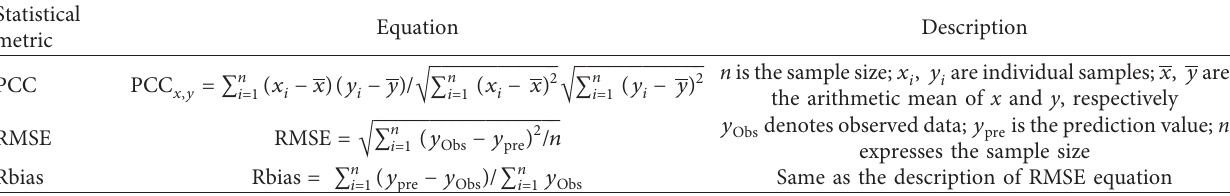
Table 4: Detailed equations and description of the statistical metrics.